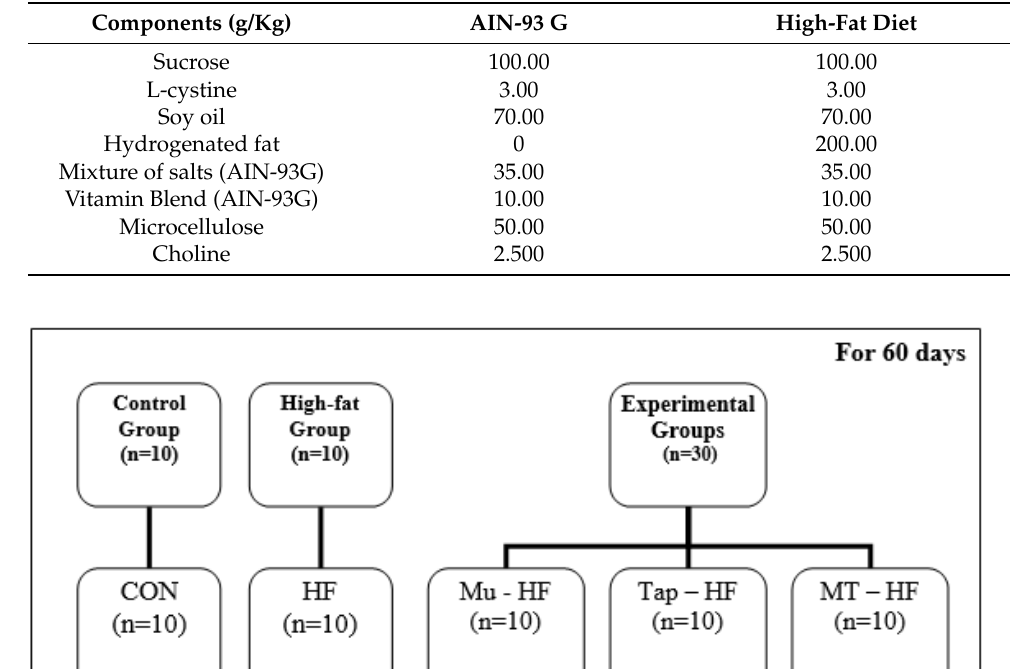
Table 1. Composition of the high-fat diet (20% lipid) prepared at the Experimental Nutrition Labor-